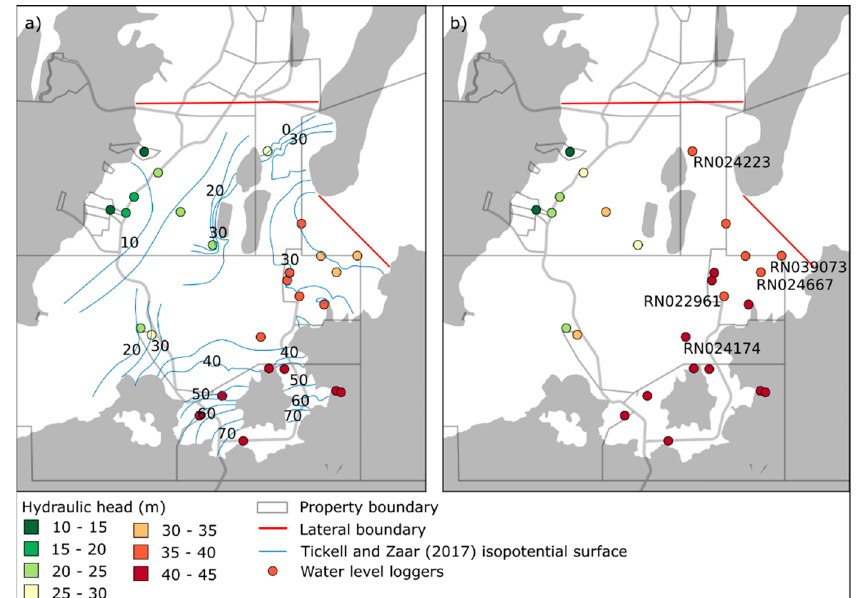
Figure A3. Location of water level loggers and hydraulic head observation ( a ) at the end of the dry season (1 December 2016) and ( b ) at the end of the wet season (1 April 2017). ( a ) Includes an interpretation of the isopotential surface by [50]. ( b ) Includes the names of the water level loggers used for estimation of gradients across the lateral boundaries.